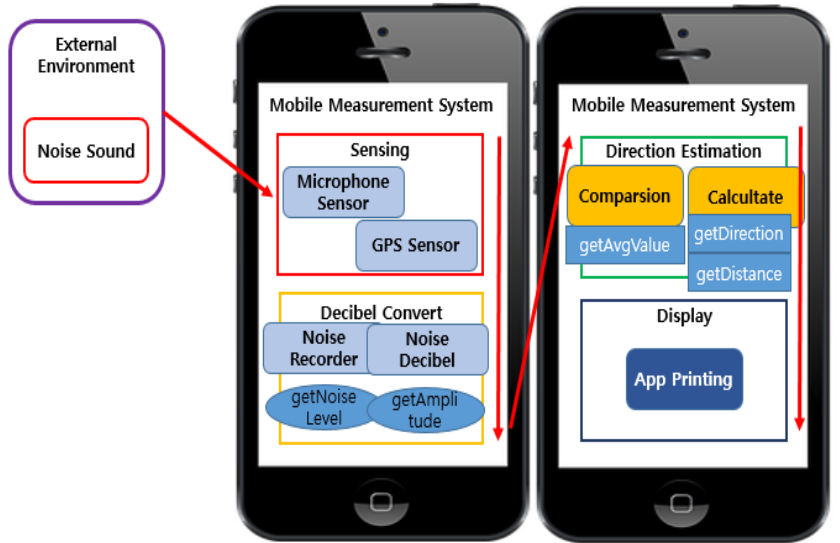
Figure 5. Structure of the proposed system